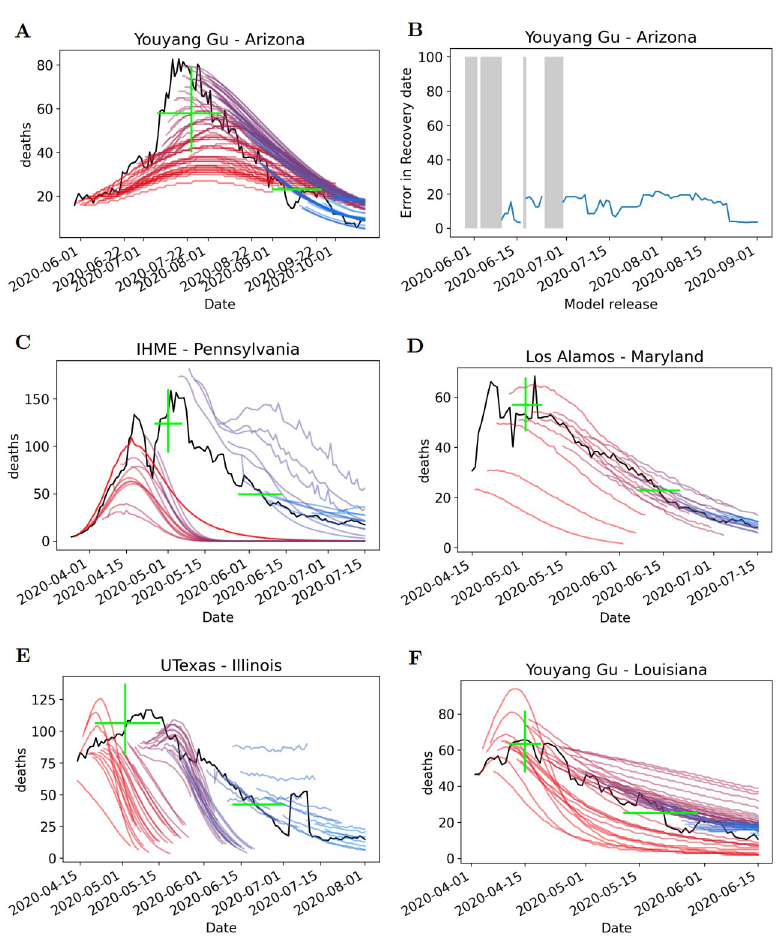
Fig 10. Visualization of recovery predictions for various peak events of four different models. Shaded grey region (s) indicate no date of recovery was predicted. A) The Arizona Summer 2020 peak YYG’s multi-release predictions are shown along with B) its error in prediction of recovery date. C–F) Example multi-release plots for other